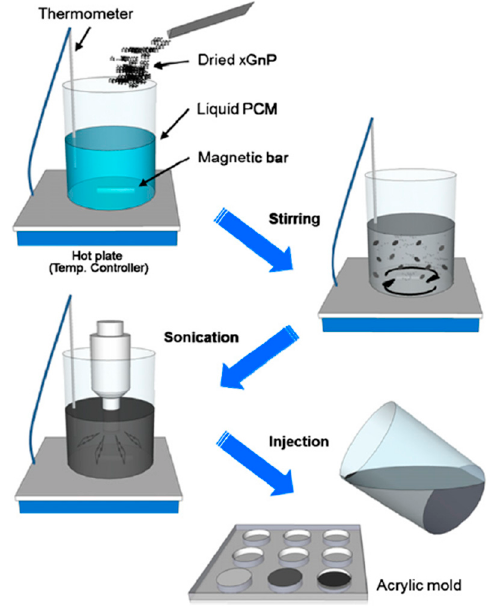
Figure 2. Stirring and Sonication of xGNP nanoparticles into PCM. (Reprinted with permission from ref. [28]. Copyright 2012 Solar Energy Materials and Solar Cells.